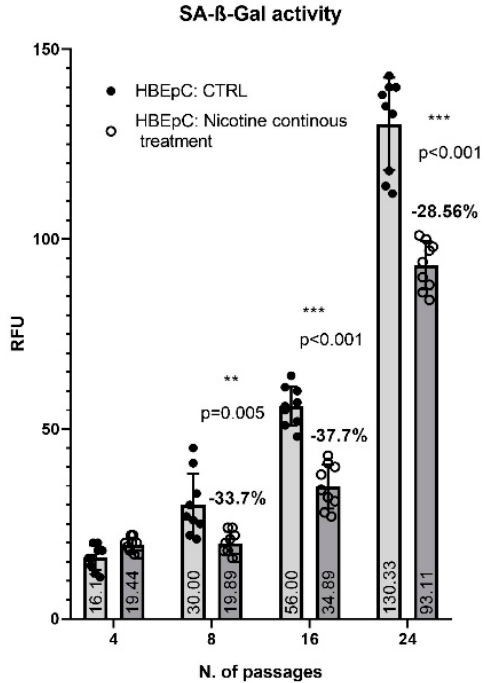
Figure 3. SA- β -Gal in HBEpC exposed continuously to nicotine. Experiments are performed at least two times in triplicate.